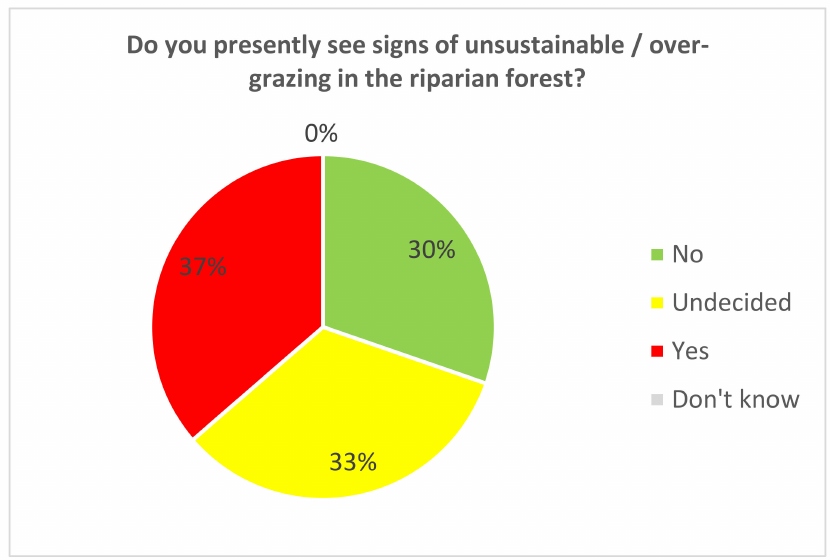
Figure 8. Over-grazing assessment by inhabitants of Ak-Tal Village (Ak-Tal HHS